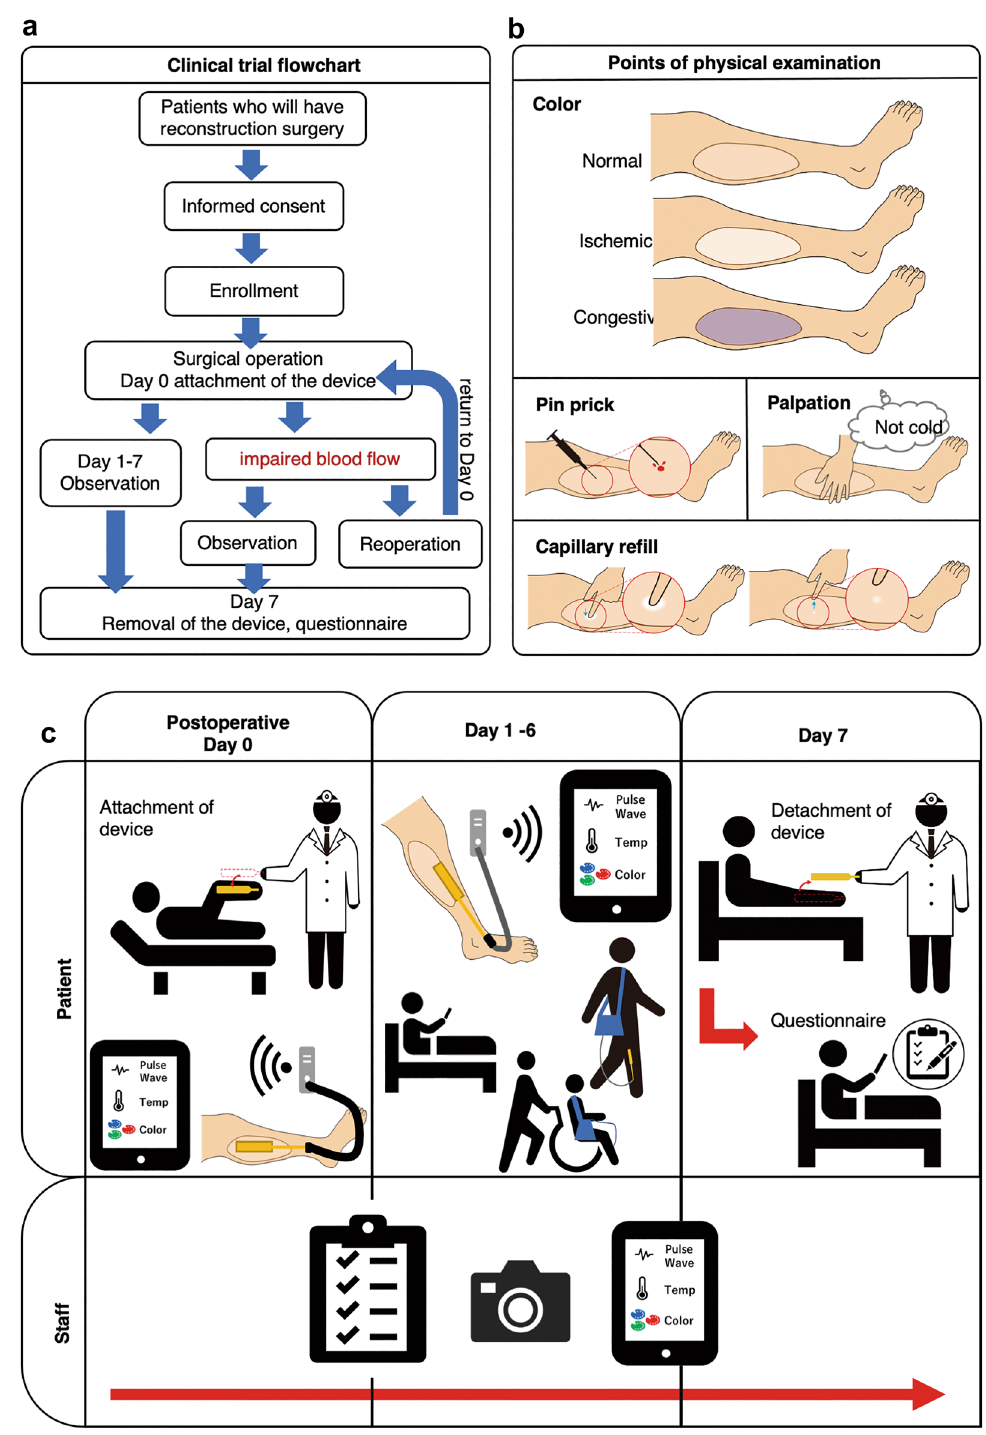
Figure 1. Overview of study workflow. ( a ) Flowchart of the clinical trial. Participants undergoing tissue transplant surgery provided informed consent and were fitted with the blood flow monitoring device at the graft site until postoperative day 7. ( b ) Concurrently, typical physical examinations of the graft site were performed twice daily by surgeons, as per the usual routine. Those assessments were observation of the tissue colour to determine whether it was ischemic or congestive, pin prick findings, where the tissue is pricked using a needle and the colour and speed of bleeding are observed, palpation to determine the temperature of the transplanted tissue, and a capillary refill test, which is a quick test to observe blood flow through peripheral tissue by compressing the tissue until it turns white and observing the time taken for the colour to return. ( c ) On the day participants underwent transplant surgery, the blood flow monitoring device was attached. Over 1 week, monitoring data collected from the device were transmitted to a tablet by a Bluetooth transmitter; thus, patients were not restricted from getting out of bed. Twice a day, surgeons performed the exam, recorded their findings, and provided a diagnosis of whether the tissue had sufficient circulation. Clinical photographs were also taken for comparison with data collected from the device. The device was removed on postoperative day 7 and the device site was assessed for abnormalities and clinical outcome. Patients then completed a questionnaire about their comfort and quality of life while wearing the